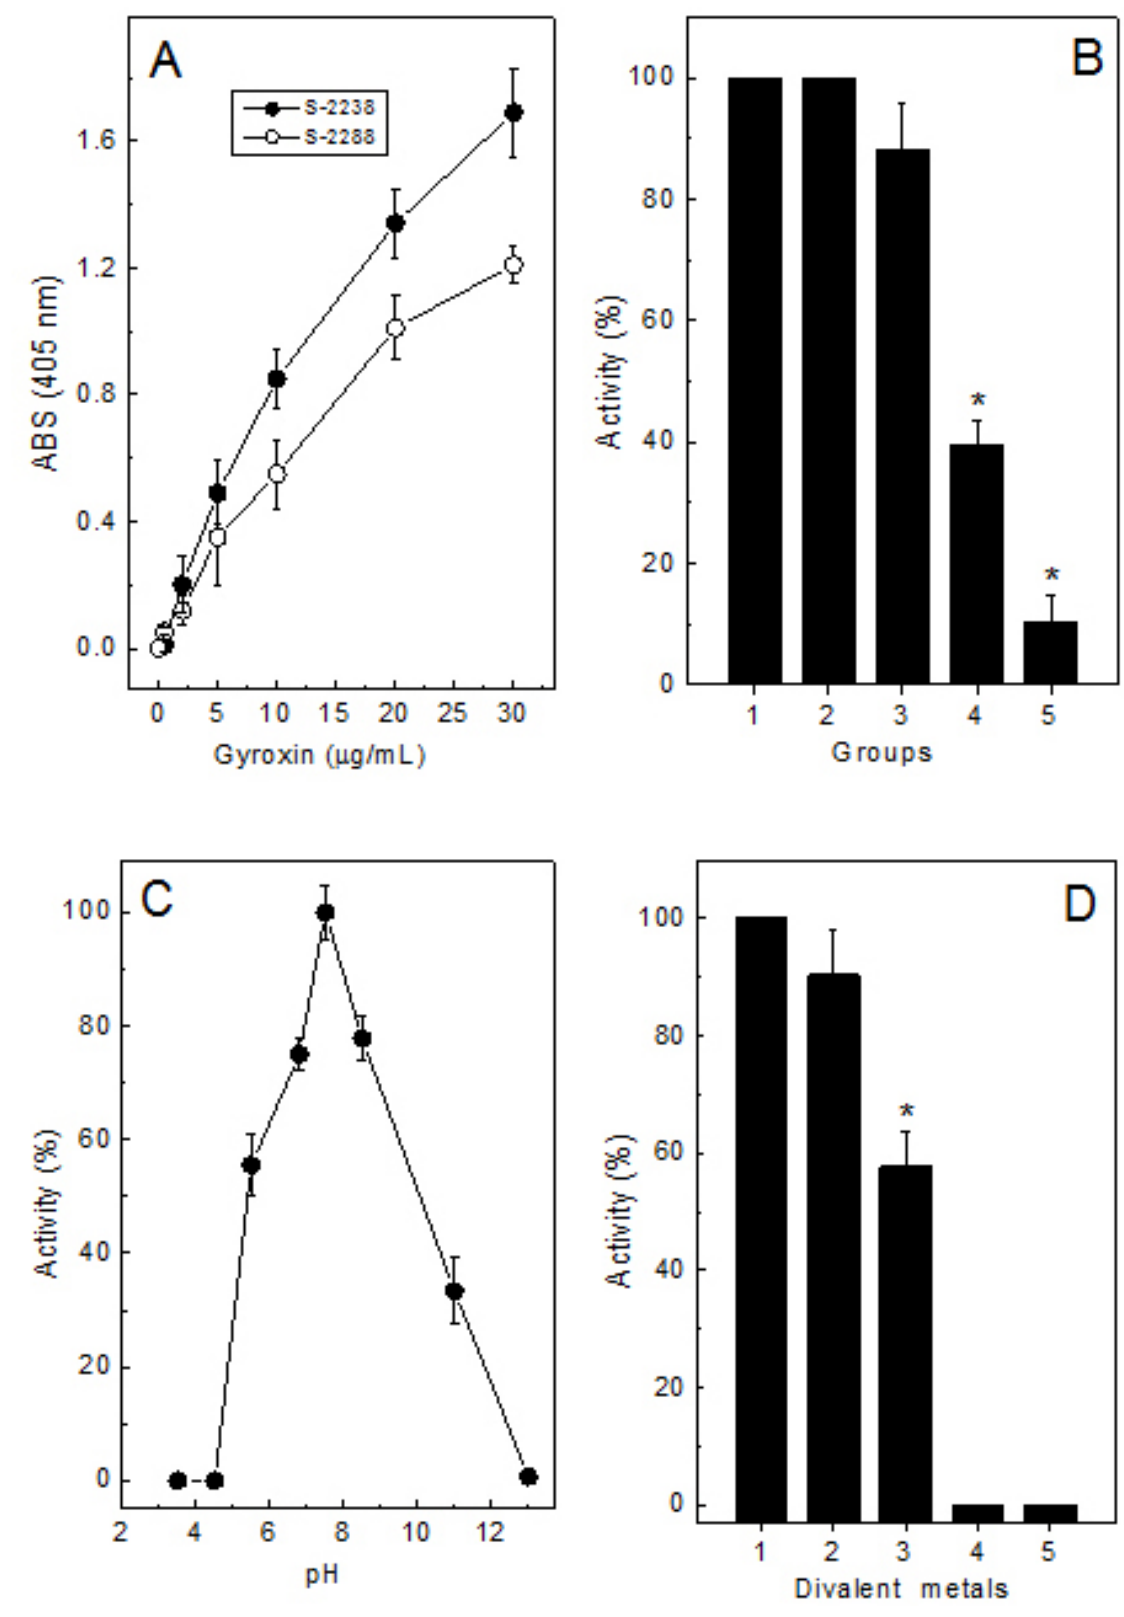
Figure 2. Gyroxin activity upon synthetic substrates (0.5 mM). ( A ) Concentration-dependent hydrolysis of S-2238 and S-2288. ( B ) Effect of inhibitors; groups: no inhibitor (column 1); 20 mM EDTA (column 2); 10 mM 1,10-phenanthroline (column 3); 20 mM PMSF (column 4) or 150 mM benzamidine (column 5). ( C ) Effect of pH (3.5, 4.5, 5.5, 6.8, 7.5, 8.5, 11 and 13) and ( D ) effect of 10 mM divalent metals: without adding any ion (column 1); Ca 2+ (column 2); Ba 2+ (column 3); Mn 2+ (column 4); Cu 2+ (column 5) on the hydrolysis of S-2238 induced by 20 µg/mL gyroxin after a 10-minute reaction at 37°C. Data are expressed as means ± SD of two individual experiments (n = 3). Asterisks (*) represent significance (p < 0.05) compared to column